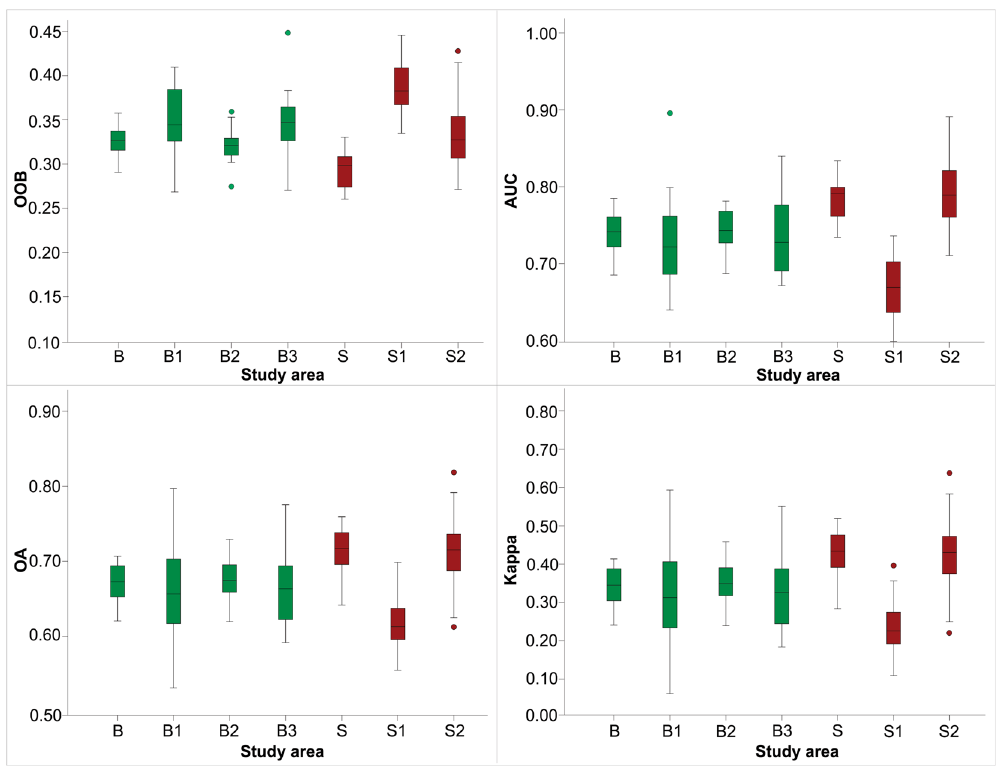
Figure 5. Distribution and variation of accuracy metrics after 20 repetitions, with one point per scarp. The Buzău study areas are shown in green; the Shizuoka study areas are shown in red. Additional explanations are found in Fig.